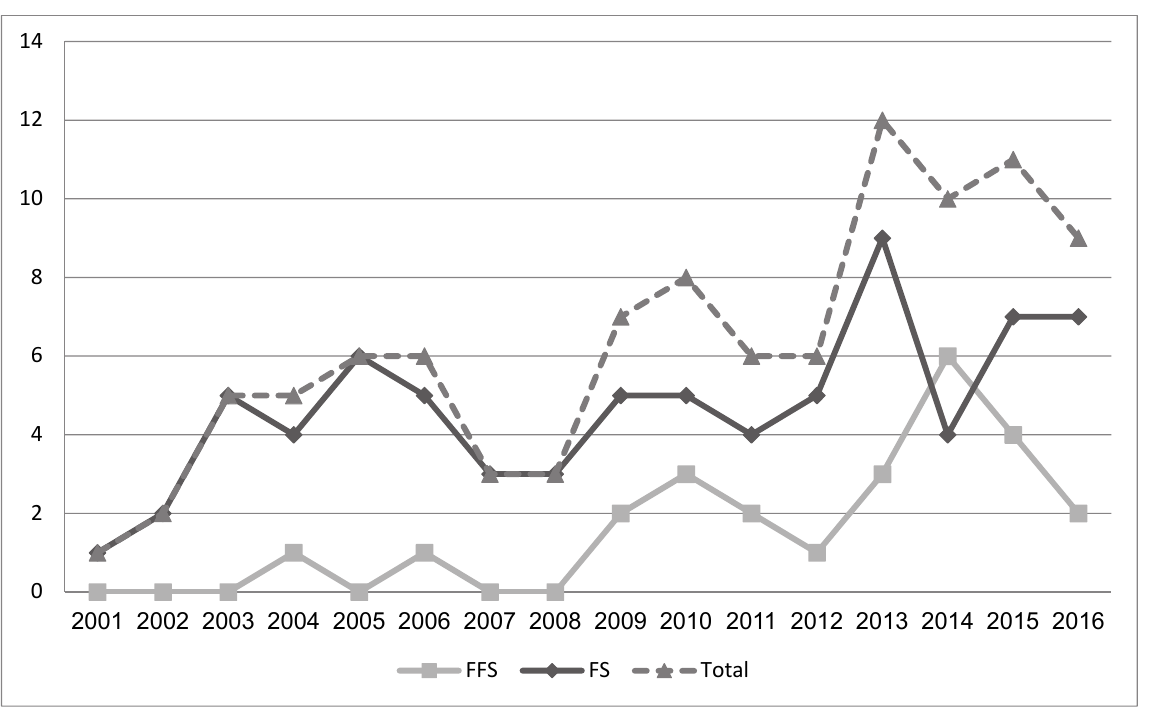
Fig. 1. Number of papers per year on FS and FFS under